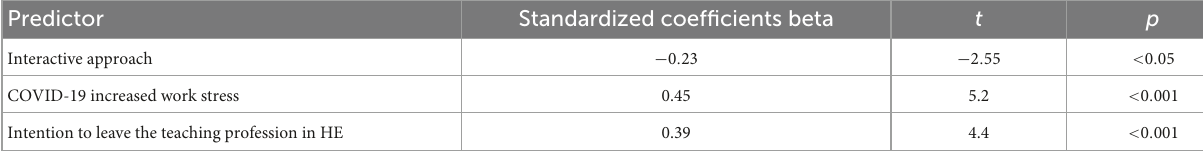
TABLE 2 Regression for predicting risk of burnout (statistically significant relations).